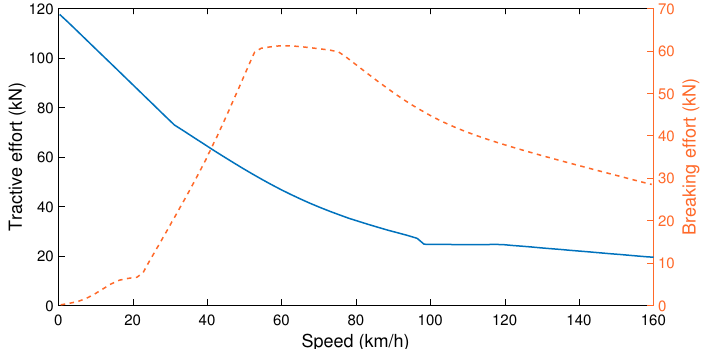
Figure 12. Tractive vs. speed profiles.